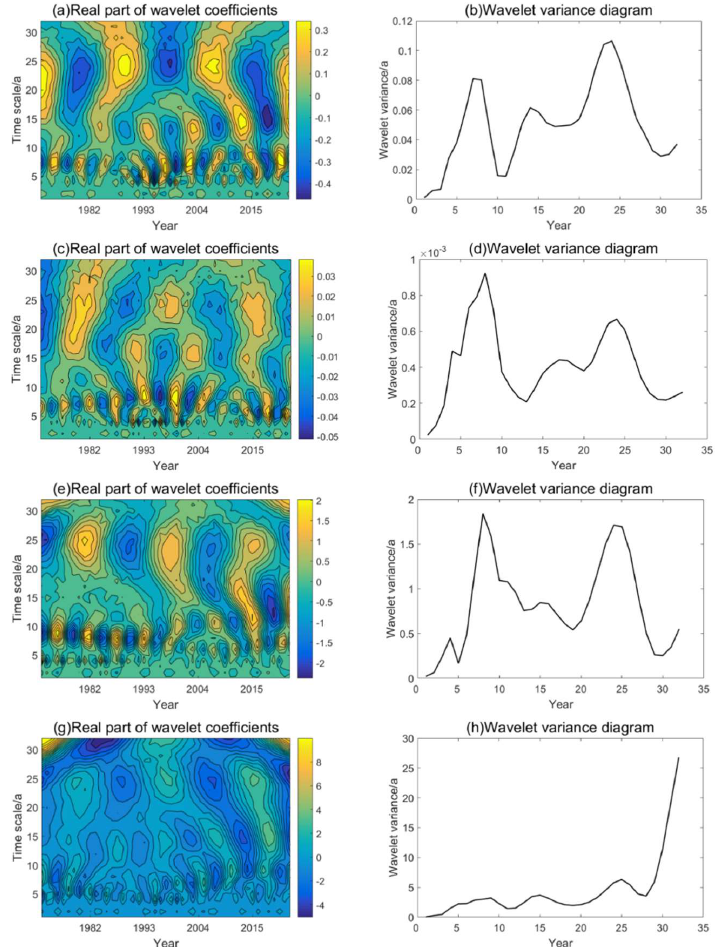
Figure 9. Wavelet analysis of precipitation, sea surface heat flux, total cloud cover, and long-wave radiation in the tropical western Indian Ocean. ( a , c , e , g ) wavelet real part; ( b , d , f , h ) wavelet variance. The main cycle of the changes in precipitation, sea surface heat flux, total cloud cover, and long-wave radiation is described in the previous article content. The wavelet coeffi- cient change diagram of the corresponding time scale is shown in Figure 10. Specifically,